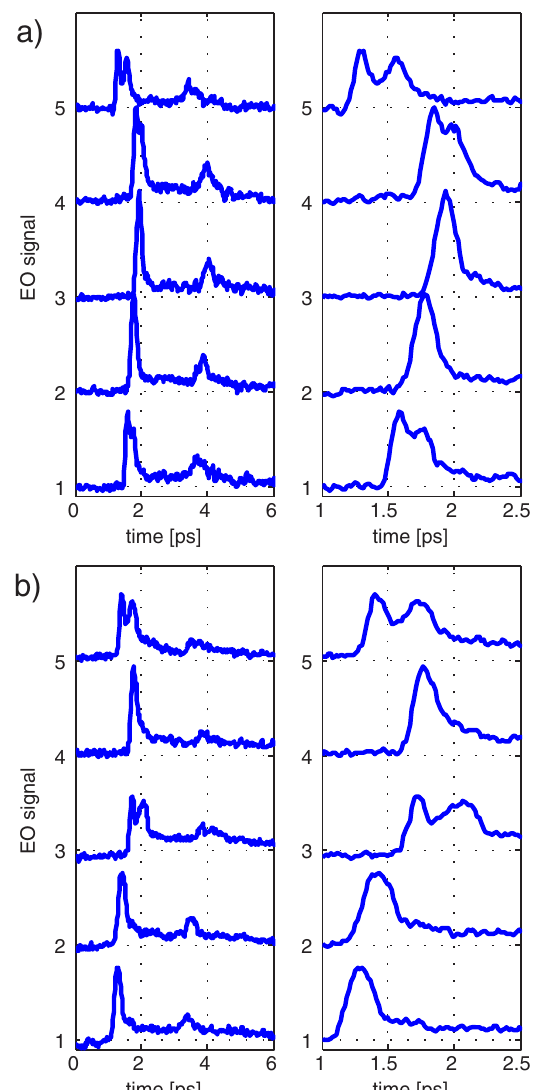
FIG. 16. (Color) EOTD traces of slightly overcompressed bunches without compression feedback at (cid:6) ¼ 0 (a) and (cid:6) ¼ 1 (cid:3) (b). The right figures show the leading peak on an enlarged time scale. A 100 (cid:1) m thick GaP crystal was used; the EO signal at about 2 ps later than the electron bunch is due to an internal reflection of the Coulomb field in the GaP